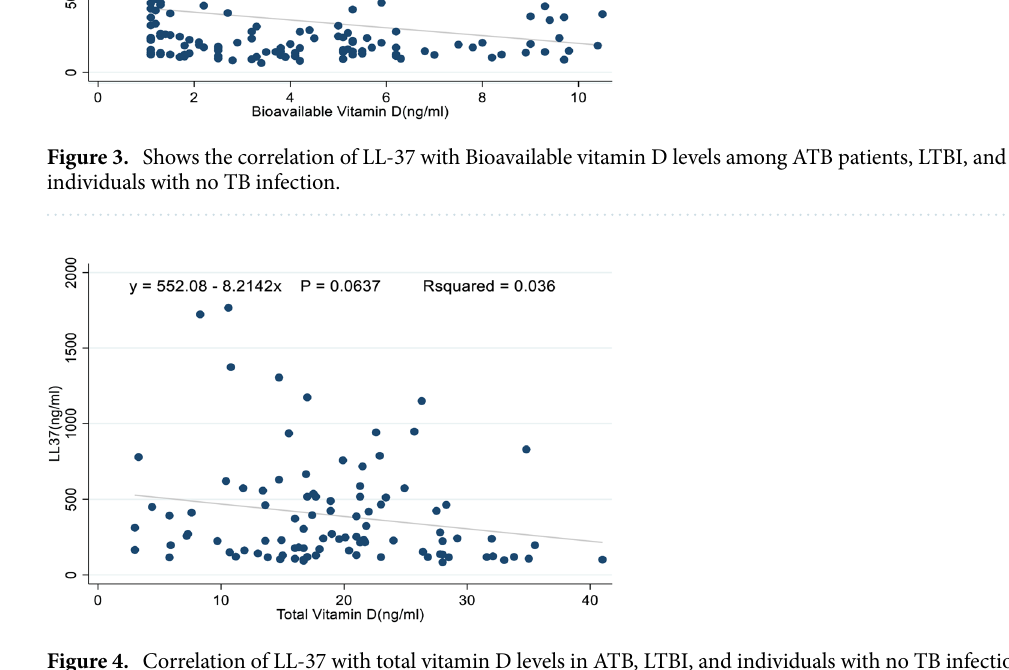
Figure 4. Correlation of LL-37 with total vitamin D levels in ATB, LTBI, and individuals with no TB